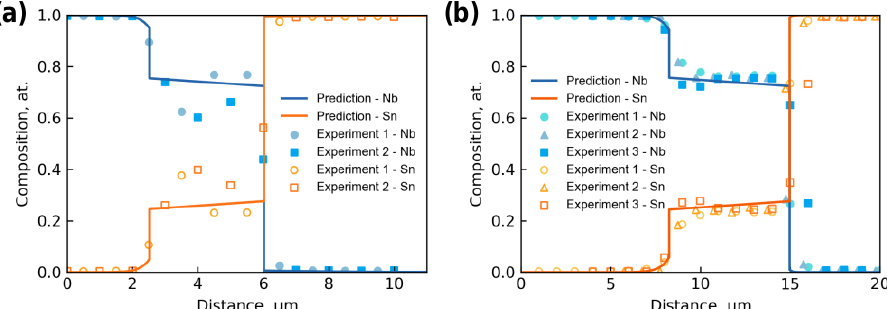
Figure 4. Experimental composition-distance profiles in the Nb/Sn LSDCs annealed ( a ) at 1100 ◦ C for 2.33 h, ( b ) at 1200 ◦ C for 2 h, compared with the corresponding model-predicted composition-distance profiles by HitDIC. Note that the caption “Experiment 1, 2 and 3” in the figures denotes the three separate measurements of composition profiles for each annealed Nb/Sn sample.